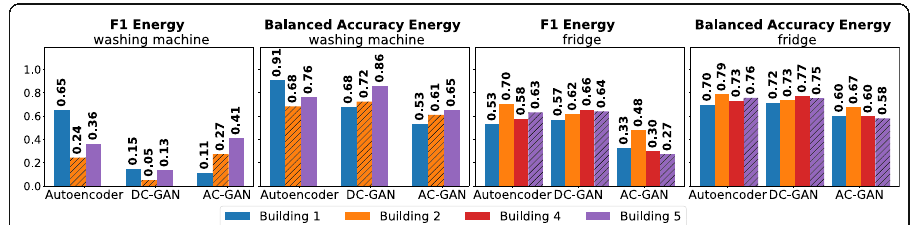
Fig. 4 Energy-based F 1 and balanced accuracy scores for the proposed and Kelly ’ s (Kelly & Knottenbelt, 2015a) Neural NILM approaches for the appliances washing machine and fridge. The approaches were only trained on the buildings with solid bars, i.e., training did not use data of building 2 for the washing machine model and building 5 for the fridge